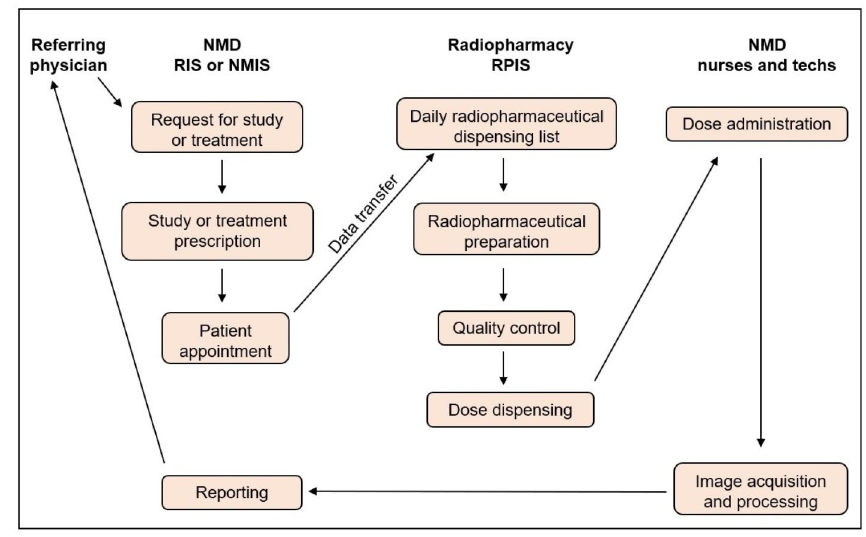
Fig. 1 Simplified workflow scheme of our nuclear medicine department